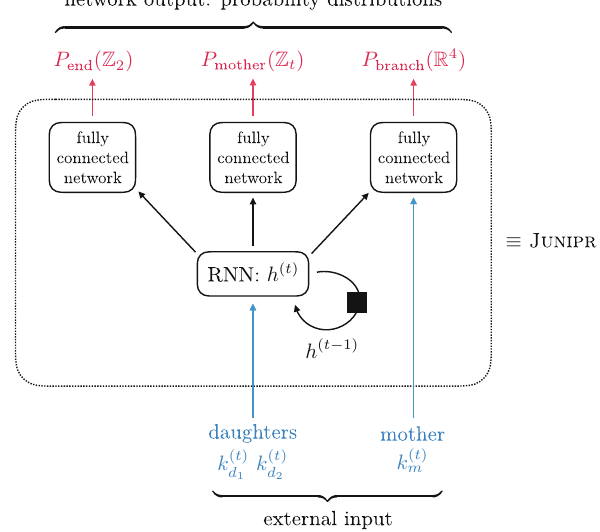
Fig. 4 Neural network implementation of the general probabilistic model proposed in Eqs. (2.2) and (2.3). The network takes as external inputs two daughter momenta and one mother momentum. The global RNN then passes only its representation vector h ( t ) to each of the dense networks shown. The networks output three full probability distribu- tions, which predict the end of the tree, the next mother to branch, and its daughter momenta